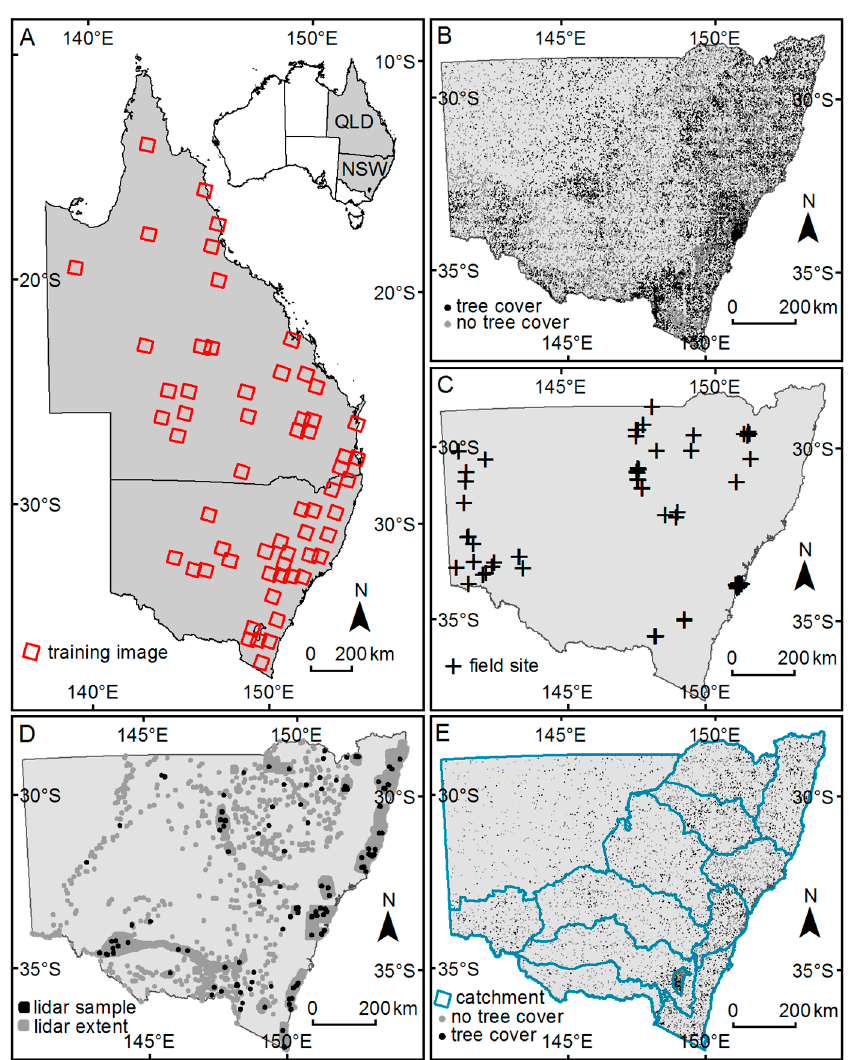
Figure 3. The distribution of training and validation datasets used in the development of the New South Wales (NSW) maps. ( A ) The location of images across NSW and Queensland (QLD) used to train the SPOT5 FPC model using Landsat FPC data; ( B ) Sites used to train the probability model interpreted from high resolution (0.5–2.5 m) imagery; ( C ) Sites of field measured FPC, used to validate the SPOT5 FPC map; ( D ) The sample of airborne lidar taken from the available lidar data used to validate the binary tree cover map; ( E ) Pixels interpreted from high resolution (2.5 m) imagery used to validate the binary tree cover map, which were stratified by catchment.